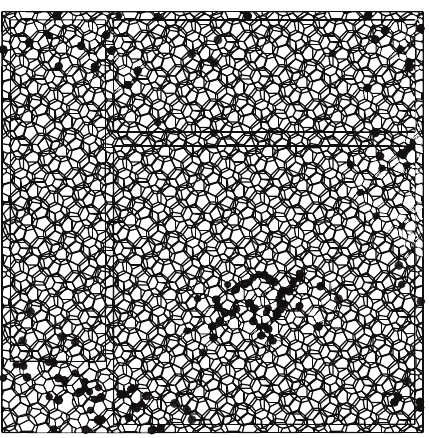
Figure 3: The plastic hinge state of roof by moment 𝑀 𝑦 .